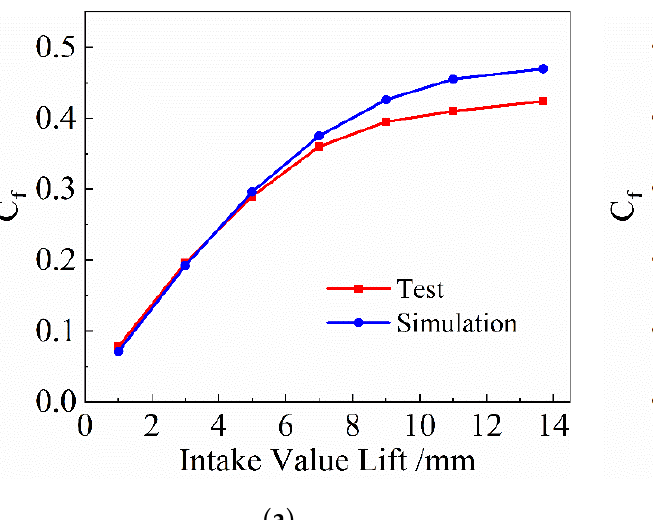
Figure 7. ( a ) Test results of different throat intake ports; ( b ) test results of different throat exhaust port.